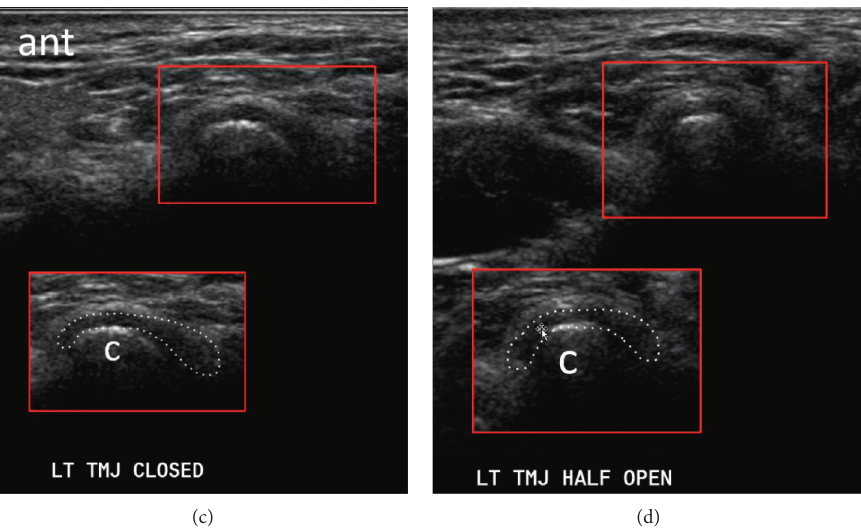
Figure 6: Images demonstrating posterior displacement of the disc in the (a) closed-mouth position with MRI, (b) recapture in the open- mouth position with MRI, (c) closed-mouth position with US, and (d) recapture in the open-mouth position with US. A focal annotated view was provided to aid visualization with the articular disc outlined with a dotted contour; anterior � “ant”; condyle � “c”; left �